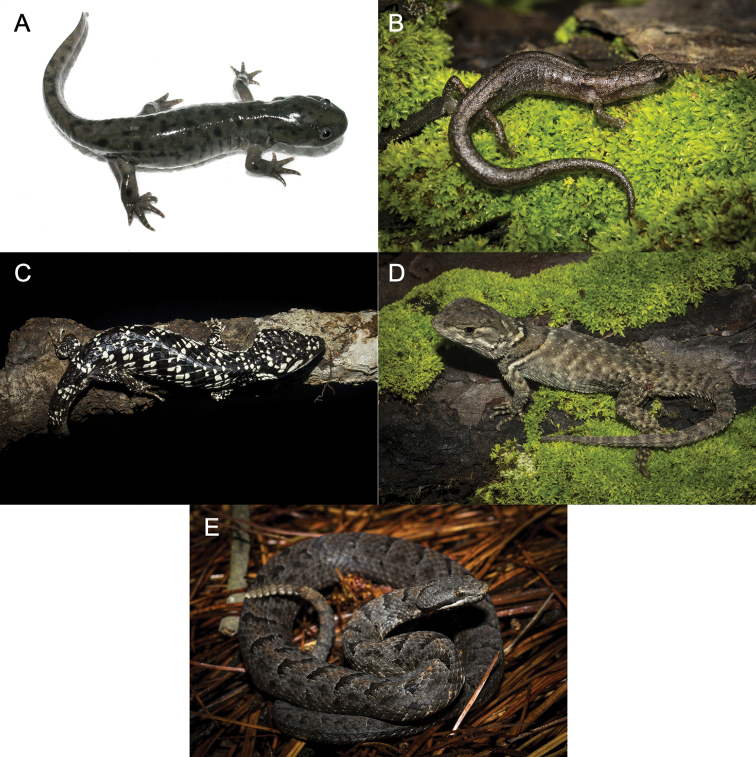
AAmbystoma
lermaenseBChiropterotriton
orculusCAbronia
deppiiD juvenile Sceloporus
sugillatusECrotalus
transversus. Photos by Eric Centenero-Alcalá